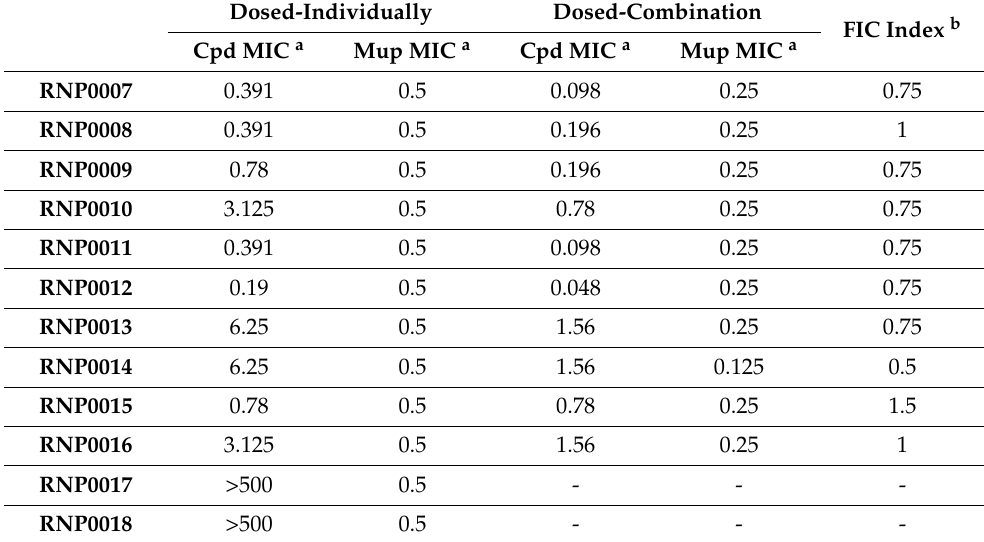
Table 3. Fractional inhibitory concentration (FIC) testing of analogs with mupirocin against S. aureus